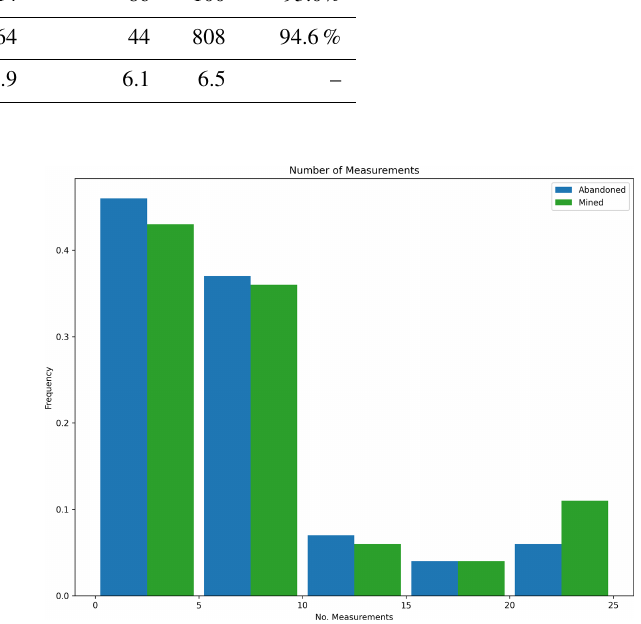
Figure 28. Measurement histogram, POMCPOW without action constraints, multiple ore bodies. This figure shows a histogram of the number of measurements taken by the POMCPOW solver over all Monte Carlo trials. The trials were limited to a maximum of 25